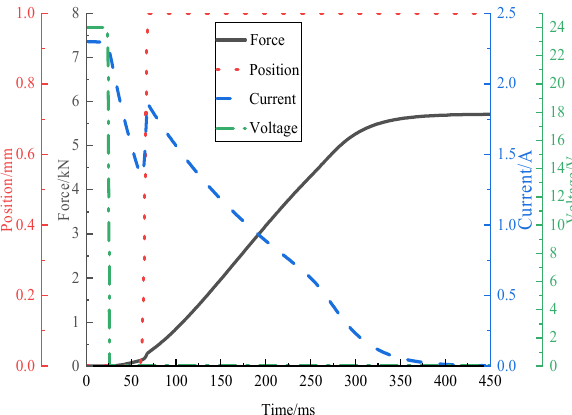
Figure 11. Transient analysis of permanent magnet brake at 105 °C .